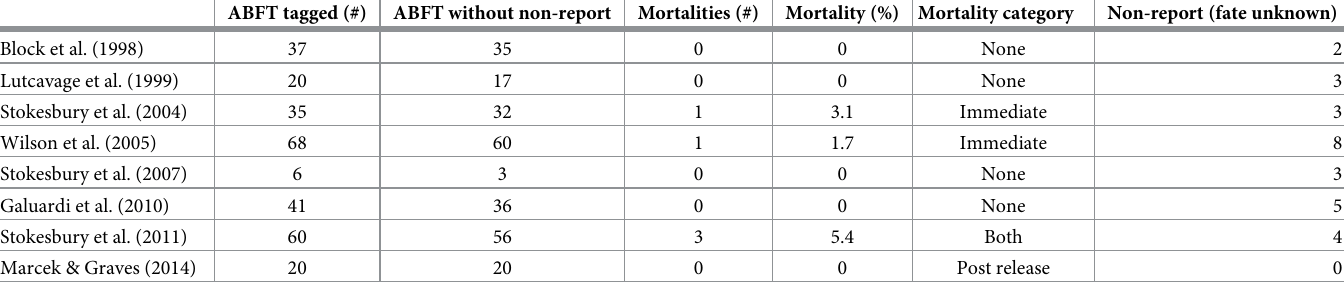
Table 1. Mortalities of ABFT caught and released using rod and reel. [14, 16–22]. Mortality in % is calculated based on the number of ABFT tagged minus the number of nonreports divided by the number of mortalities. Mortality categories include mortalities immediate (e.g. at-vessel), post-release mortality, both or none if no mortalities were observed. Both immediate and post-release mortality were counted when calculating the mortality